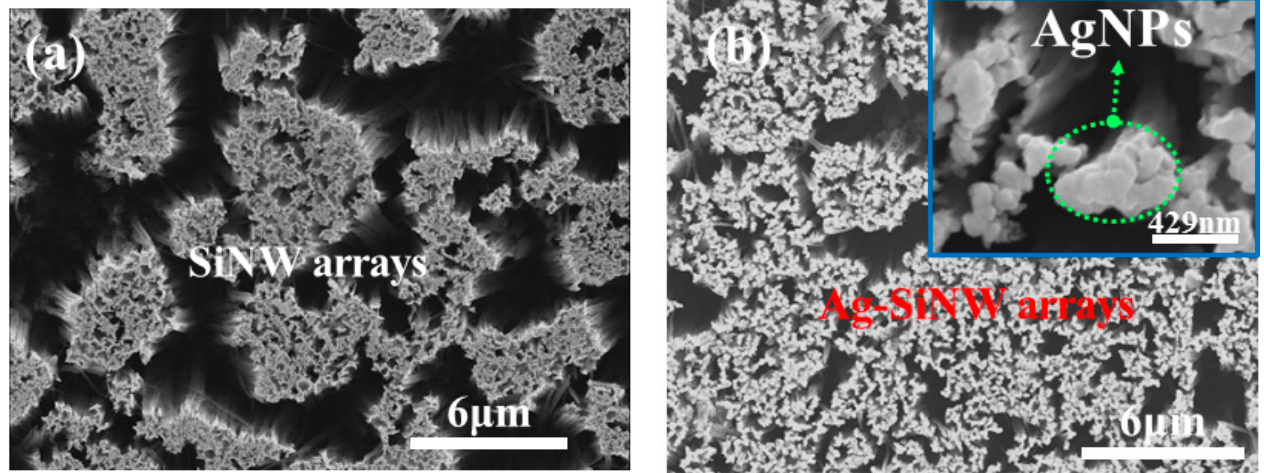
Figure 2. SEM images of ( a ) the p-SiNW arrays (×5.0) and ( b ) the SiNWs deposited with AgNPs (×5.0) and the image with high resolution (×70.0).